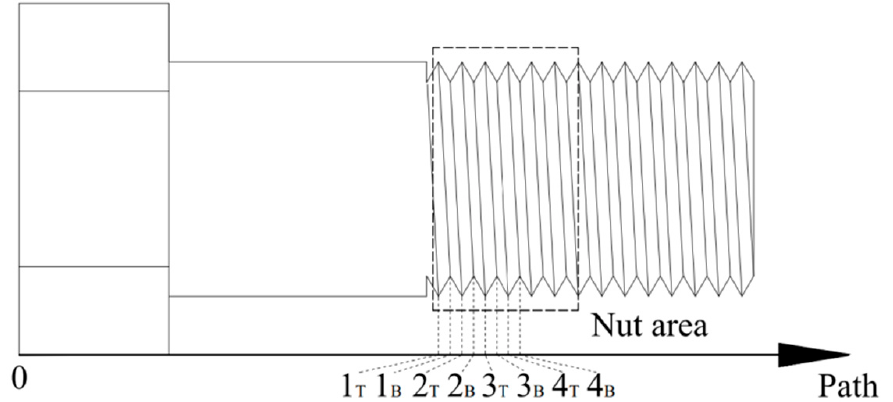
Figure 9. Schematic diagram of the extracted bolt path.